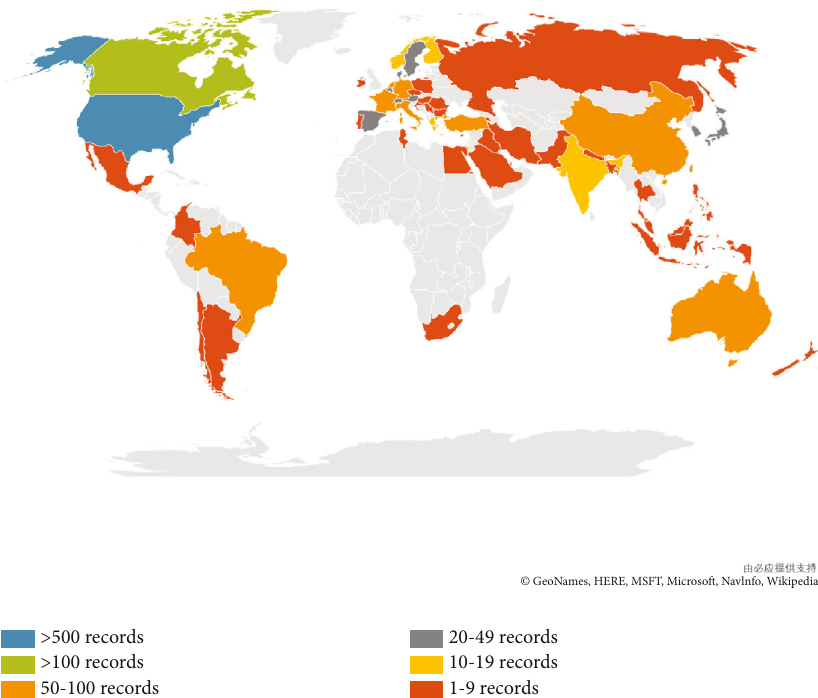
Figure 3: World map of total country output based on neuropathic pain rehabilitation research.